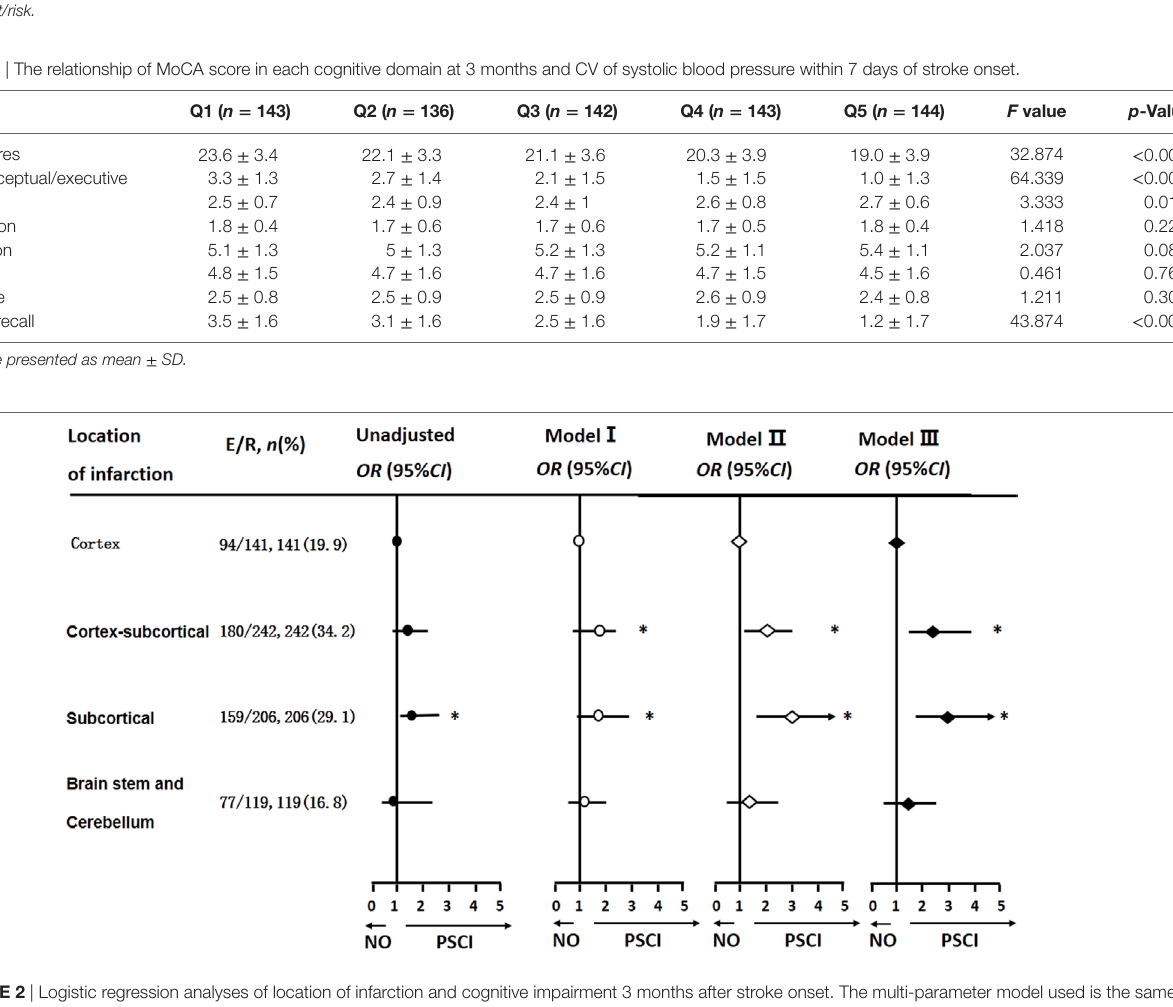
FigUre 2 | Logistic regression analyses of location of infarction and cognitive impairment 3 months after stroke onset. The multi-parameter model used is the same as that used in Table 2 .